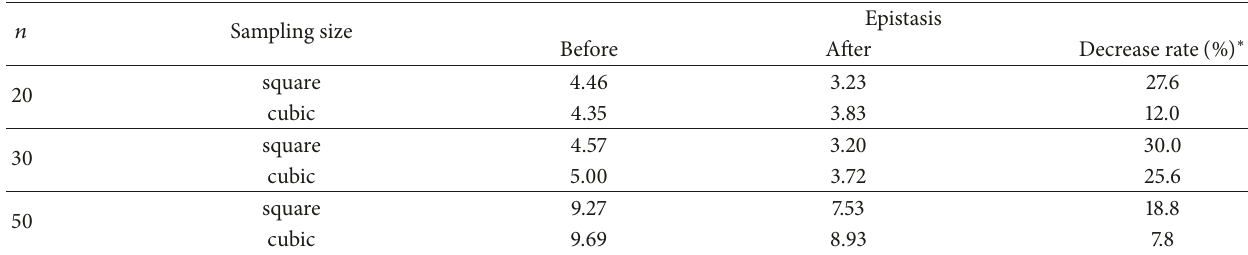
Table 5: Epistasis of the original and modified basis sampling in the variant-onemax